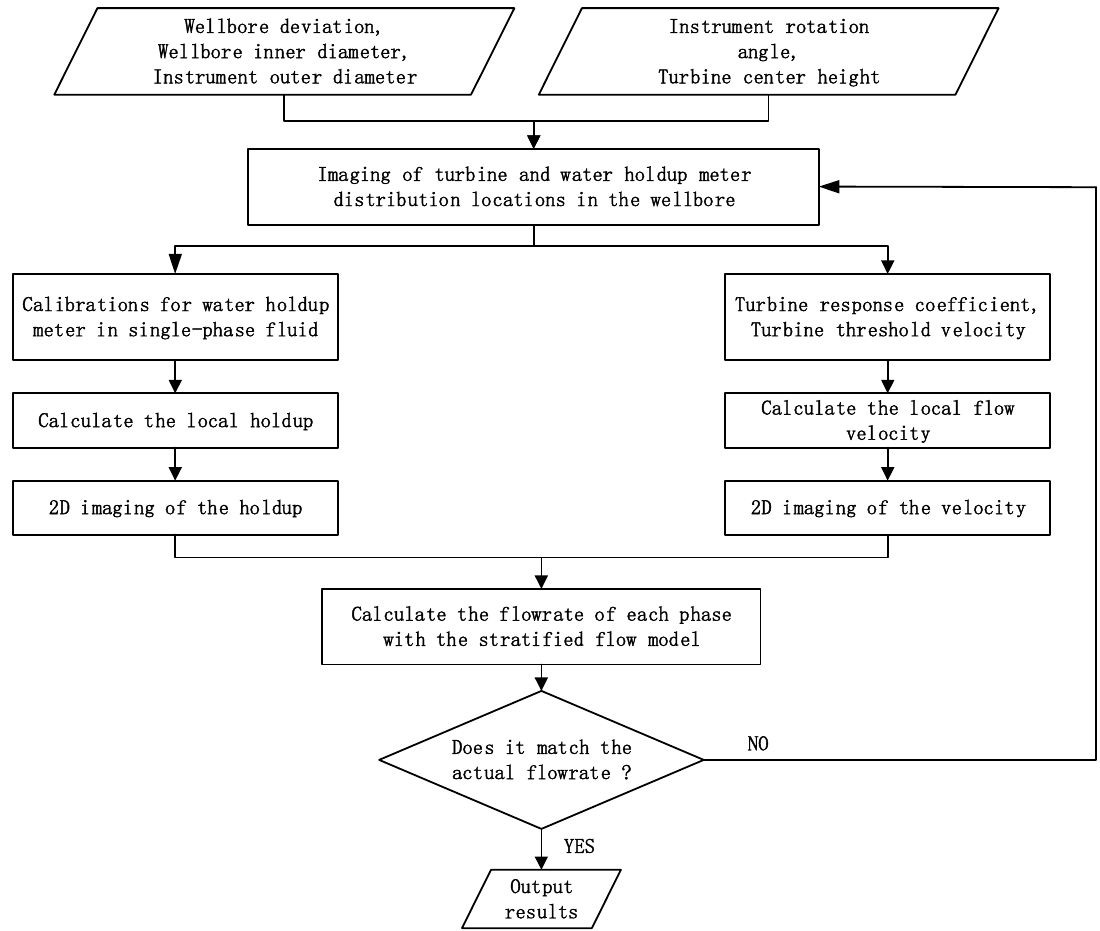
Figure 8. The design idea of the program.